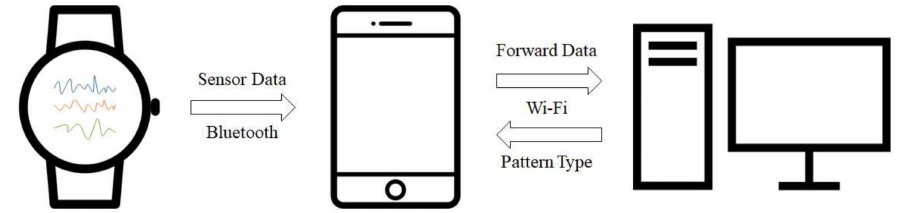
Figure 1. Overall system architecture.